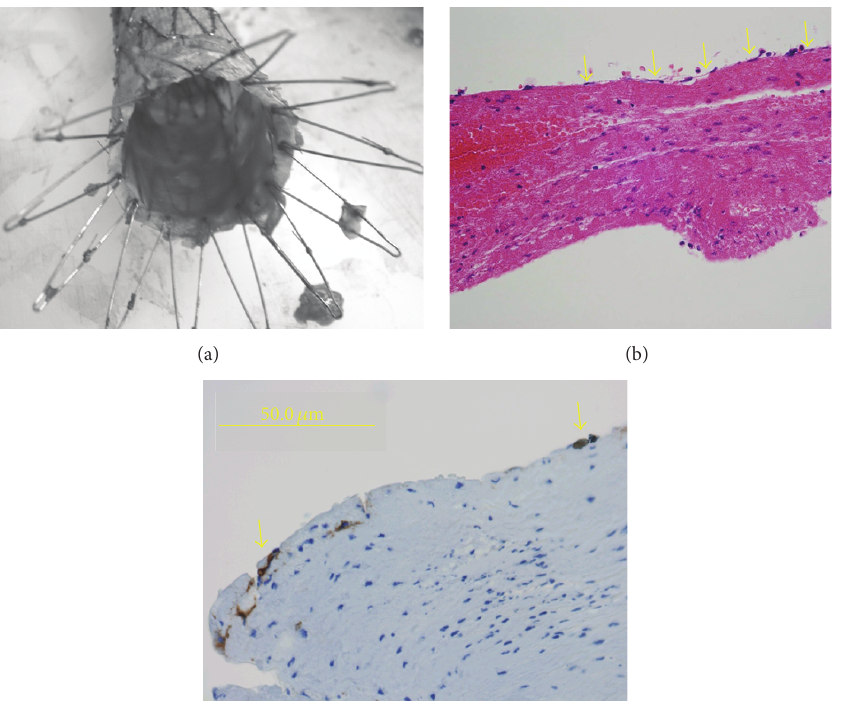
Figure 3: (a) The retrieved stent graft. A thin membranous layer covered the luminal surface of the graft. (b) Microscopic examination indicatingthepresenceofamembranouslayer,includingcellularcomponentsliningonthesurface(arrows)(hematoxylinandeosinstaining). (c) Endothelial cells were observed on the innermost surface of the layer (arrows) (anti-CD34 antibody